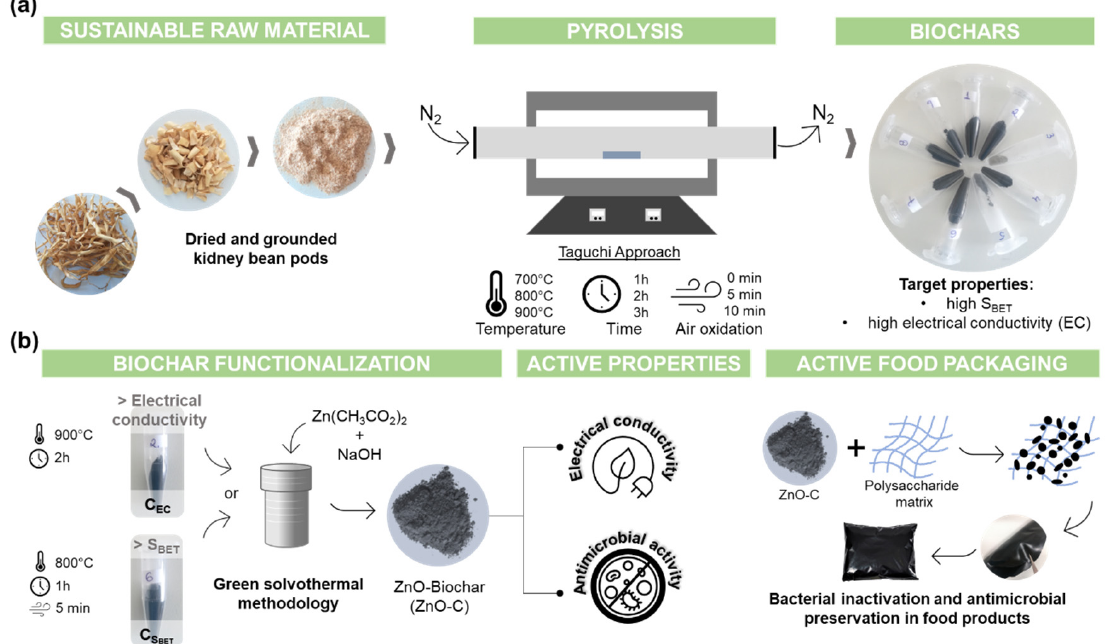
Figure 1. Workflow of ( a ) biochar production derived from kidney-bean-pod pyrolysis using a Taguchi approach to obtain biochars with distinct characteristics, and ( b ) biochar functionalization with ZnO particles by a solvothermal methodology obtaining composites to be used as fillers in a biopolymeric matrix for active food packaging.